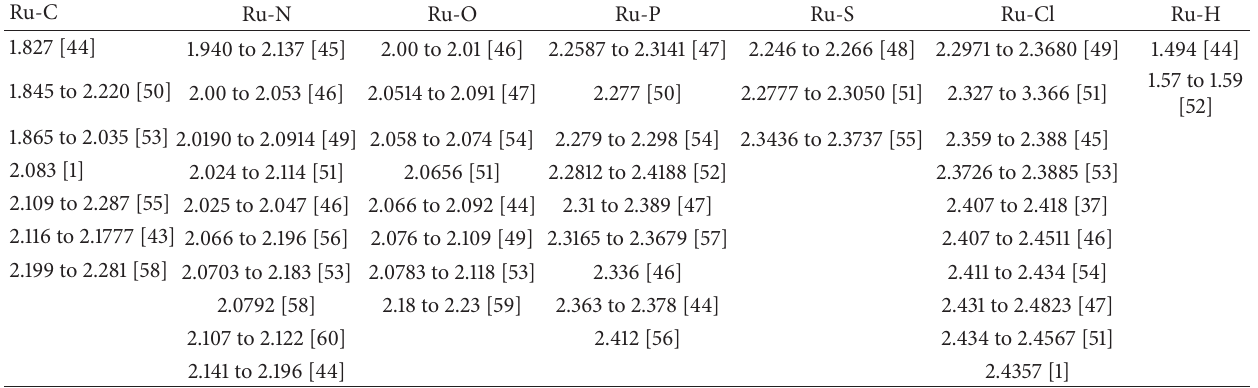
Table 1: The experimental bond distances for Ru-L which are found to be common in different ruthenium complexes.